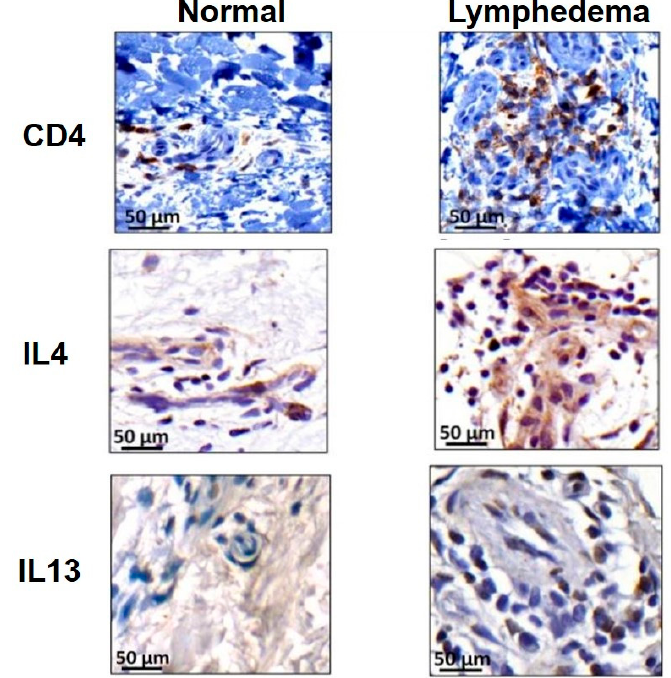
Figure 1. Representative immunohistochemistry images demonstrating CD4 + (upper), IL-4 + (middle), and IL-13 + (lower) cells in matched human biopsy specimens comparing lymphedematous and contralateral normal upper extremities. Reprinted with permission from supplemental figure 1 [26].